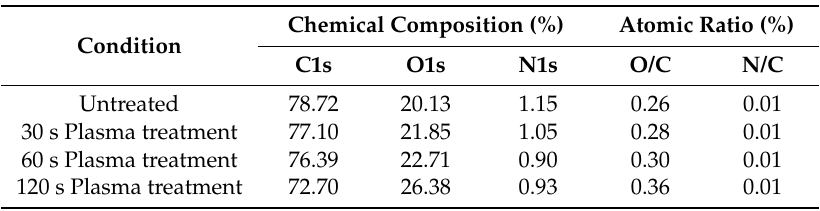
Figure 5. XPS survey spectrum of untreated POM fiber and fiber subjected to DBD plasma treatment for different durations. Table 2. Relative chemical composition and atomic ratios determined by XPS for untreated POM fiber and for fiber after DBD plasma treatment.